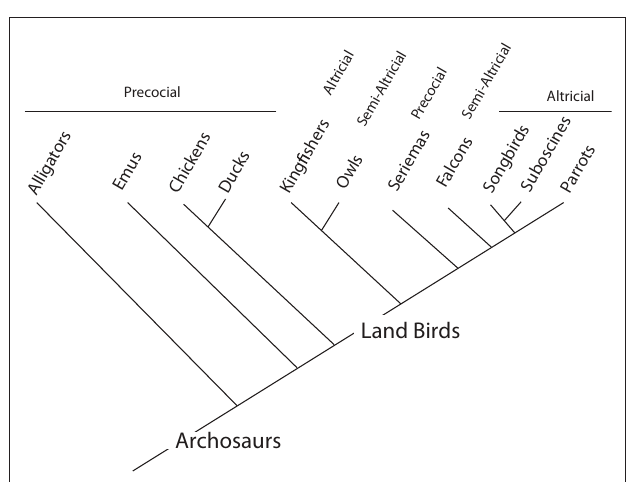
Figure 2 | Phylogeny of archosaurs (alligators and birds) shows their modes of development. Parrots, songbirds, suboscines (manakins, antbirds, tyrant-flycatchers), and kingfishers are altricial, whereas falcons and owls are semi-altricial. Because most land birds (e.g., suboscines and falcons) are either altricial or semi-altricial, the ancestors of parrots and songbirds were probably either altricial or semi-altricial. This, in turn, implies that the expansion of the telencephalon in parrots and songbirds evolved in a lineage that was at least semi-altricial. In contrast, many reptiles (e.g., alligators), paleognaths (e.g., emus), and basal lineages of Neoaves (e.g., galliform and anseriform birds) are precocial. Thus, ducks and geese were probably precocial when they expanded their telencephalon. The phylogeny is based on Hackett et al.